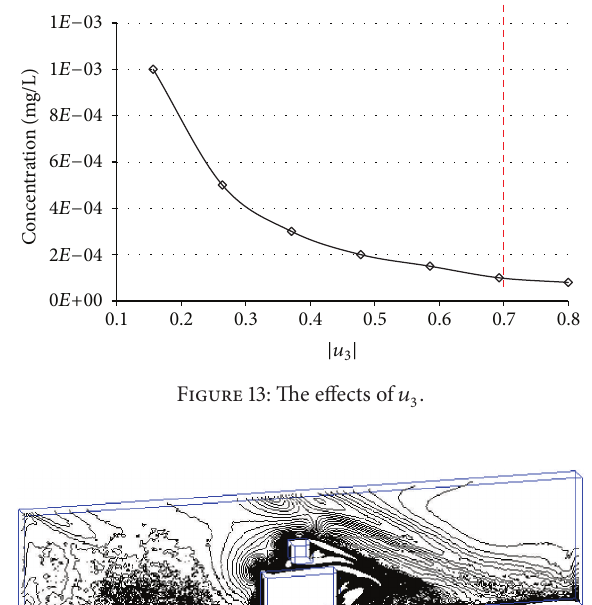
Figure 14: Isolines of